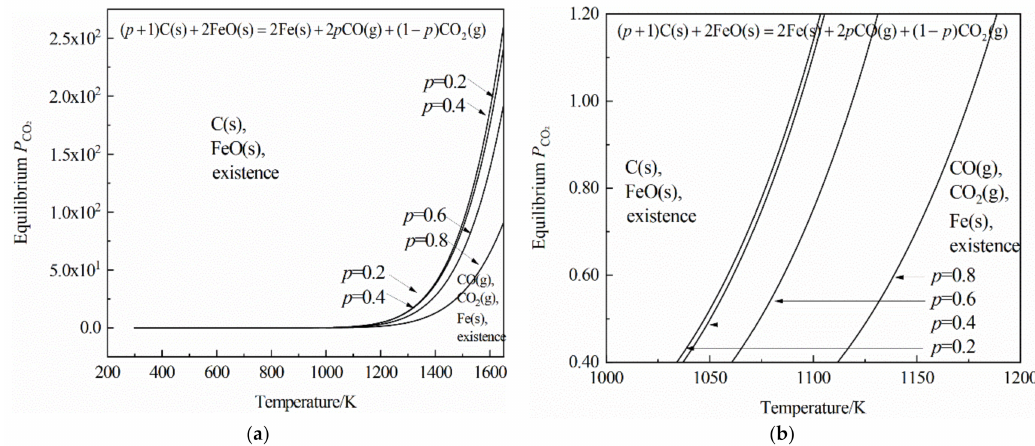
Figure 12. The equilibrium relative gas partial pressure of CO 2 as a function of temperature of the reaction of ( p + 1)C(s)